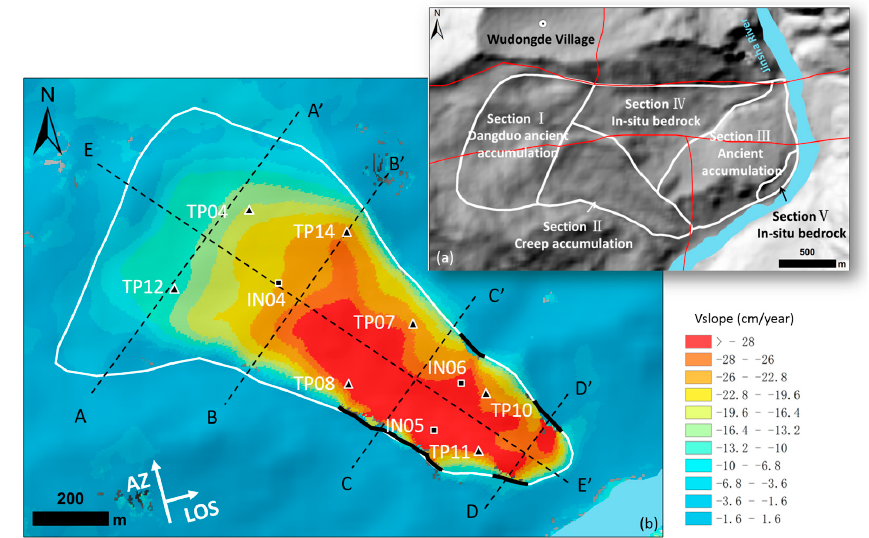
Figure 6. Jinpingzi landslide maps ( a ). Zonation map of Jinpingzi landslide, including Section I, Dangduo ancient accumulation with a total volume of 60.5 million m 3 ; Section II, creep accumulation with a total volume of 27 million m 3 ; Section III, ancient accumulation with a total volume of 108 million m 3 ; Section IV, in-situ bedrock; Section V, in-situ bedrock. The red line represents the faults. ( b ) Average deformation rate map in the downslope direction over Section II of the Jinpingzi landslide, where two triangles represent the ground monitoring points used for the following analysis, and the square represents the drill holes. The dashed lines from AA’ to EE’ denote profile locations. The black lines indicate slide-bounding strike-slip